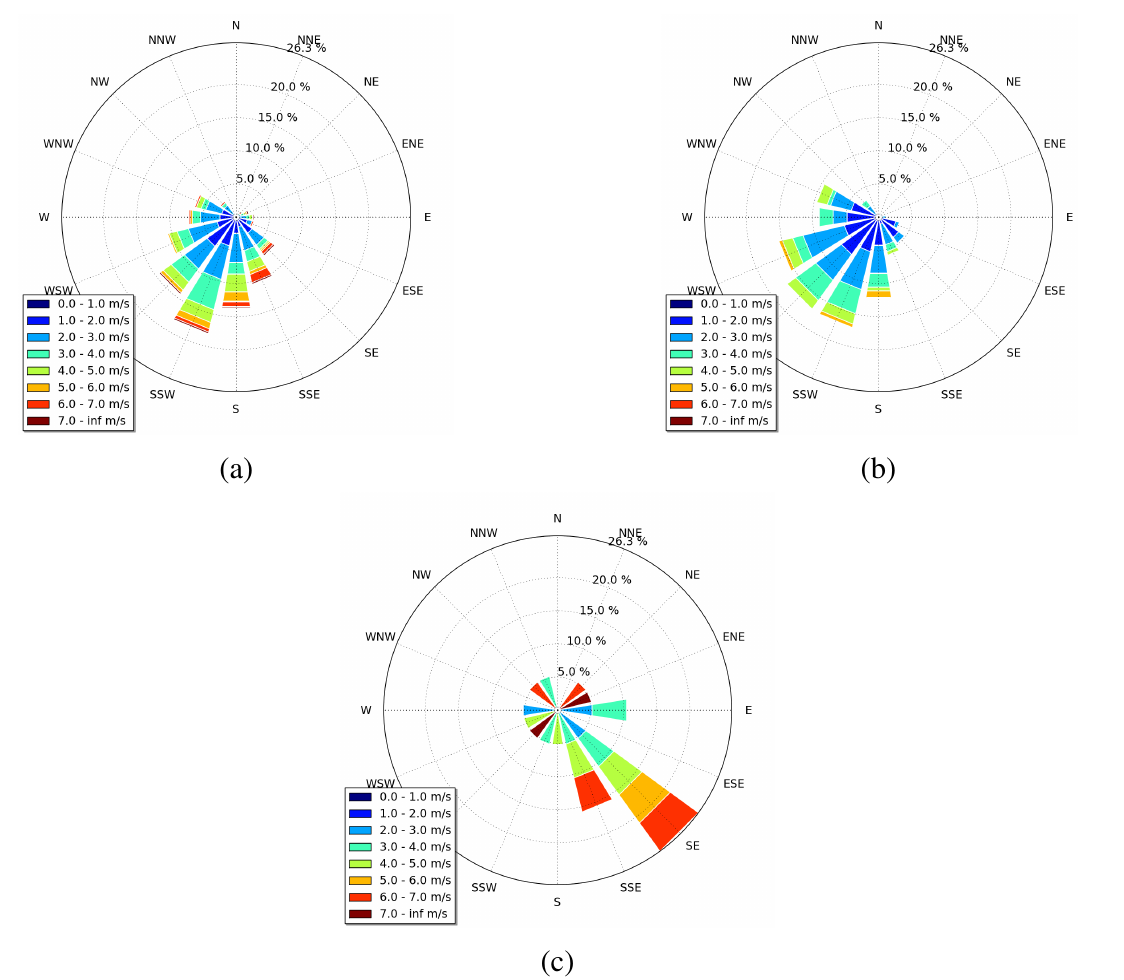
Fig. 10. Wind roses at Dome C (a) during the entire period of near-infrared pictures (from 23 November 2009 to 16 February 2010, and from 3 January 2011 to 11 April 2012), (b) when hoar is present, and (c) the set of days when hoar disappears. The cardinal direction is the origin of the wind. 36